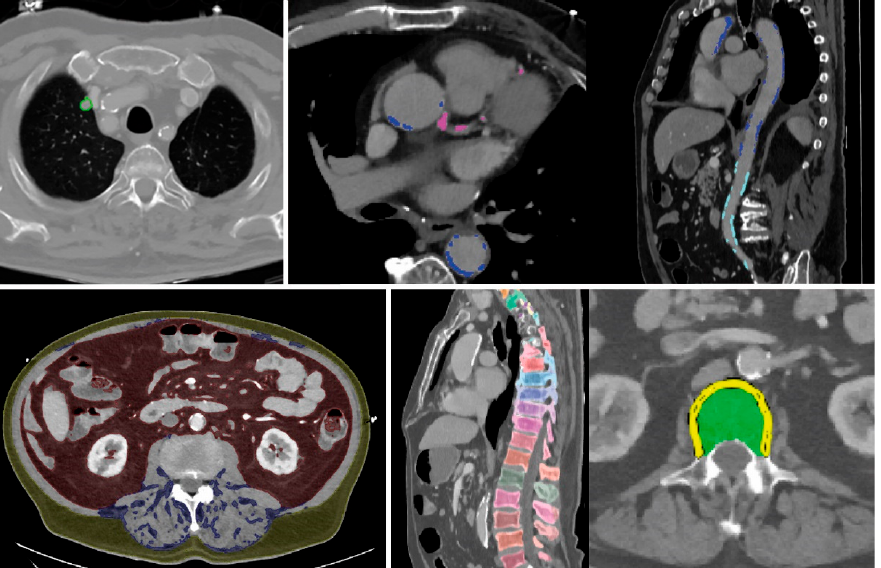
Figure 2. Example no. 1 ‘TAVI patient’—Summary of organ segmentations and pathological findings from left to right and top to bottom: pulmonary nodule of the right upper lobe, coronary and aortic calcifications, visceral, subcutaneous and intramuscular adipose tissue, and vertebral segmentations for assessment of BMD.